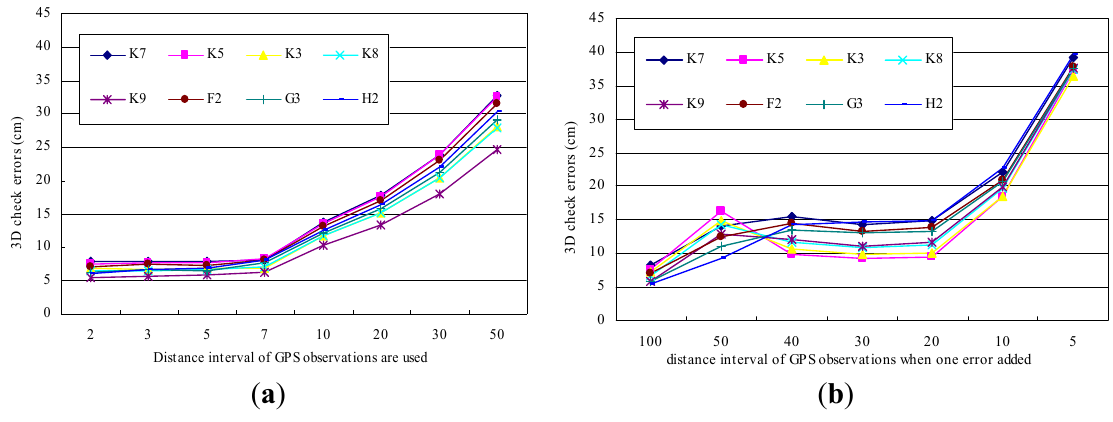
Figure 8. ( a ) Check errors vs. the number of GPS observations used. “Distance interval n ” on the X axis means that one GPS observation is selected for every n m. The check errors of all 8 GCPs increase when the number of GPS observations is reduced but are still less than 0.35 m. ( b ) Check errors vs. number of gross errors added to the GPS observations. On the X axis, “Distance interval n ” means that the gross error is added to one GPS observation every n meters. The check errors of all 8 GCPs increase when more GPS observations are given gross errors but are still less than 0.4